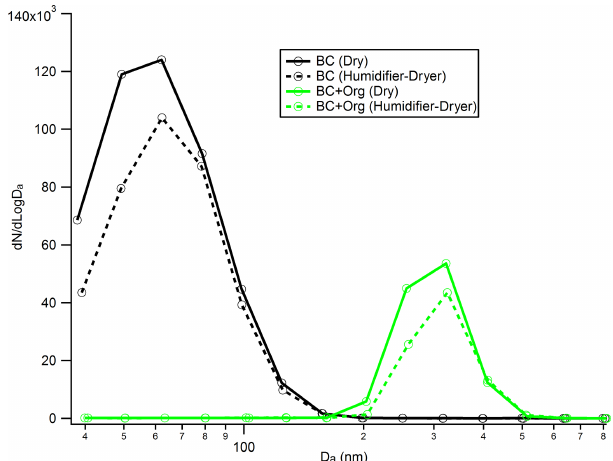
Figure 8. Number size distribution of the bare BC (black line) and organic-coated BC particles (green line) before and after they ex- perience “humidity cycling” (i.e. exposed to 90%RH around 10s and then dehydrated to 10%RH) process. D a is the aerodynamic